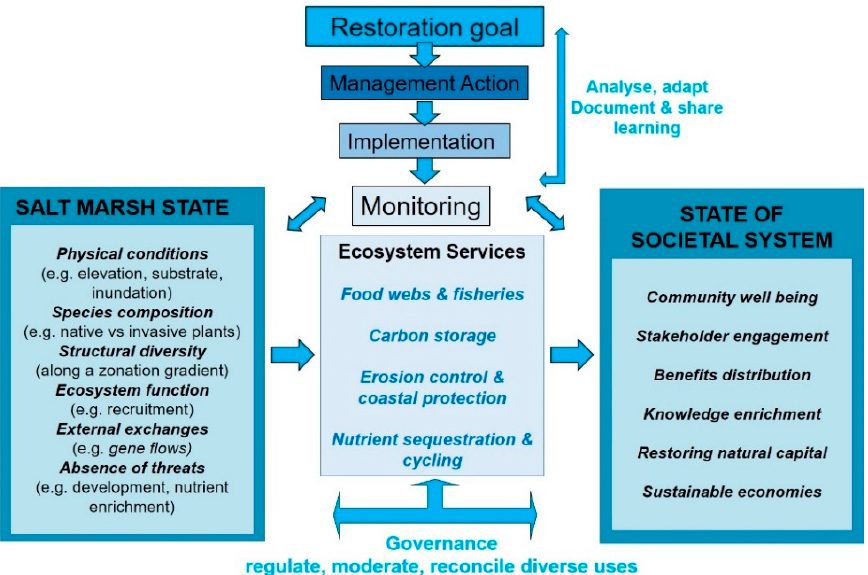
Figure 3. Socio ‐ ecological systems framework for salt marsh restoration (adapted from [50]). Figure 3. Socio-ecological systems framework for salt marsh restoration (adapted from